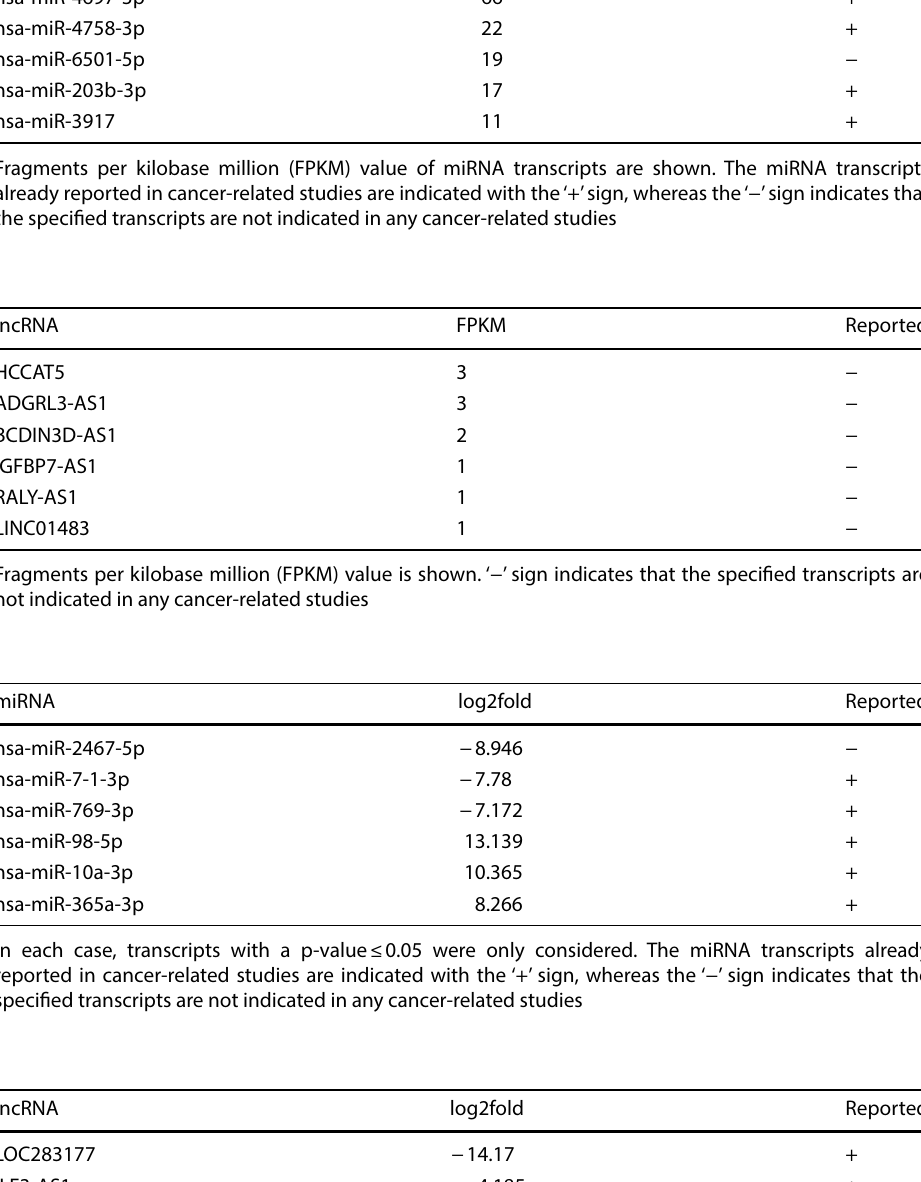
Table 6 Top six treatment- specific miRNA transcripts in OS-EP compared to OS-P cells